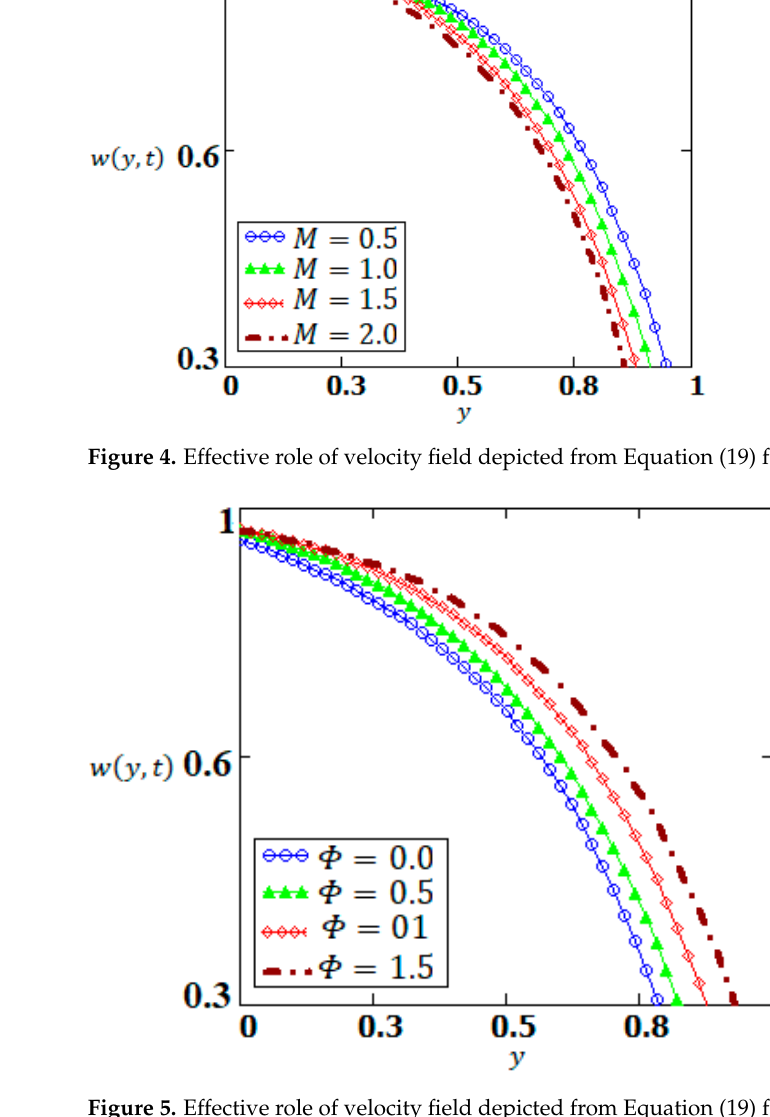
Figure 6. Comparison of velocity field depicted from Equation (19) with 𝑀 (cid:3404) 0 and 𝛿 (cid:3405) 1 , Equa ‐ tion (19) for 𝑀 (cid:3405) 0 and 𝛿 (cid:3405) 1 , Equation (19) for 𝑀 (cid:3405) 0 and 𝛿 (cid:3404) 1 .